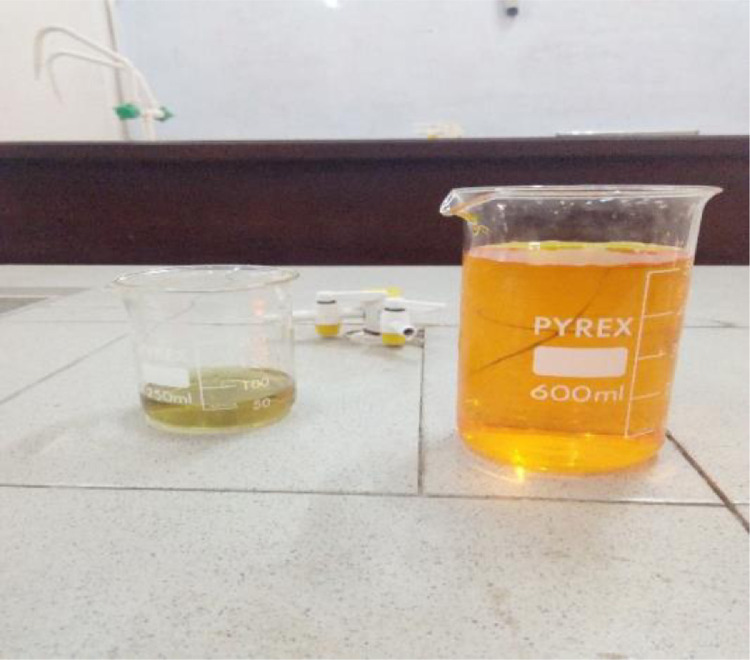
liquefied Kr2Cr2O7 and ethanol.